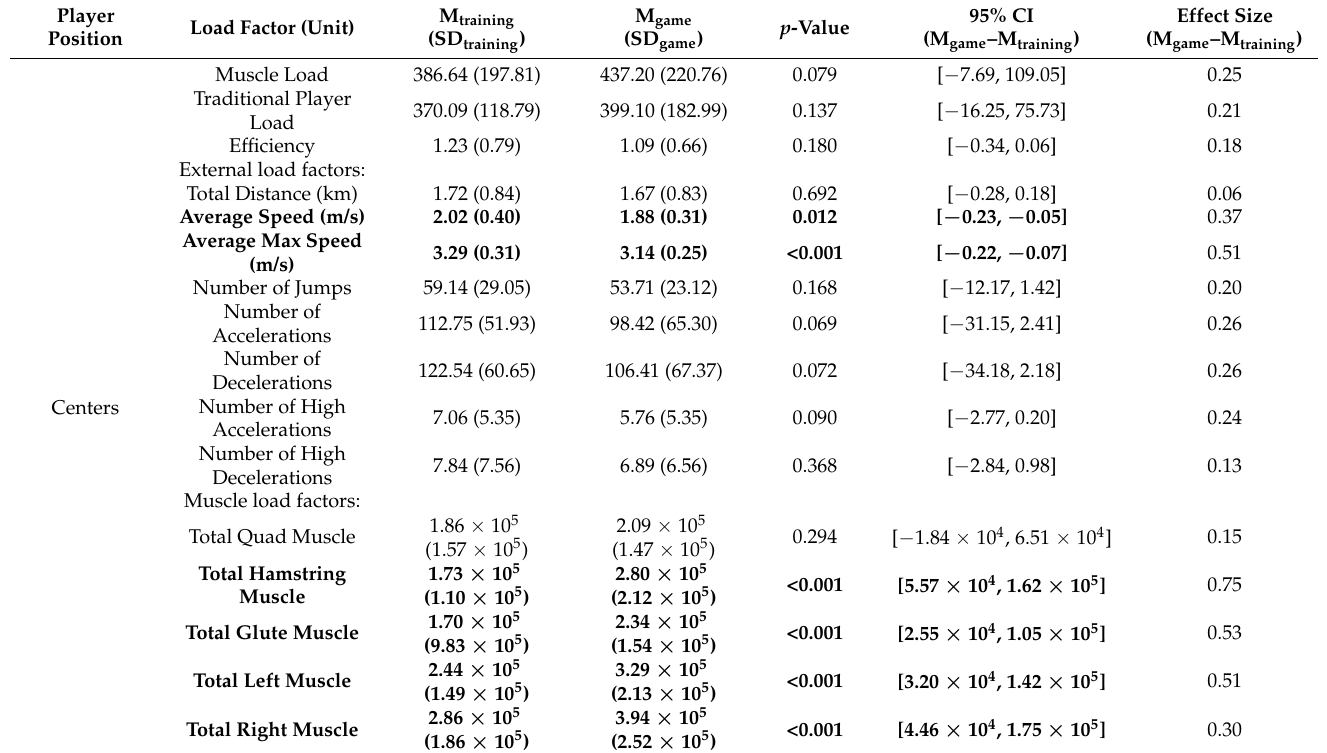
Table 3. Bootstrapping results for equality of means between training and game sessions. The variables that are statistically significant ( p < 0.05) are in bold. Effect size calculated using Hedges’ g. Guideline for interpreting effect size: trivial (ES < 0.25), small (>0.25 and <0.5), moderate (>0.5 and <1.0), and large (>1.0)